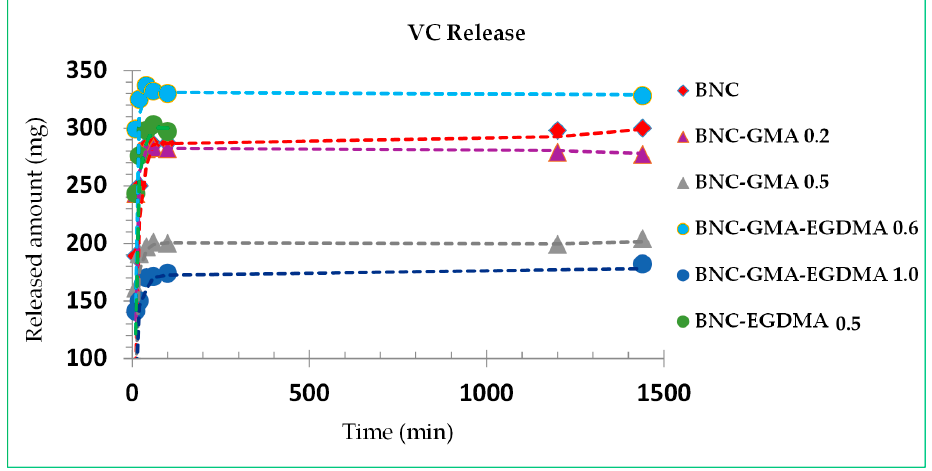
Figure 17. Kinetic of vancomycin (VC) release from BNC (red); BNC-GMA MS = 0.2 (violet) and MS = 0.5 (grey); BNC-EGDMA MS = 0.5 (green); BNC-GMA-EGDMA MS = 0.6 (light blue) and MS = 1.0 (blue).